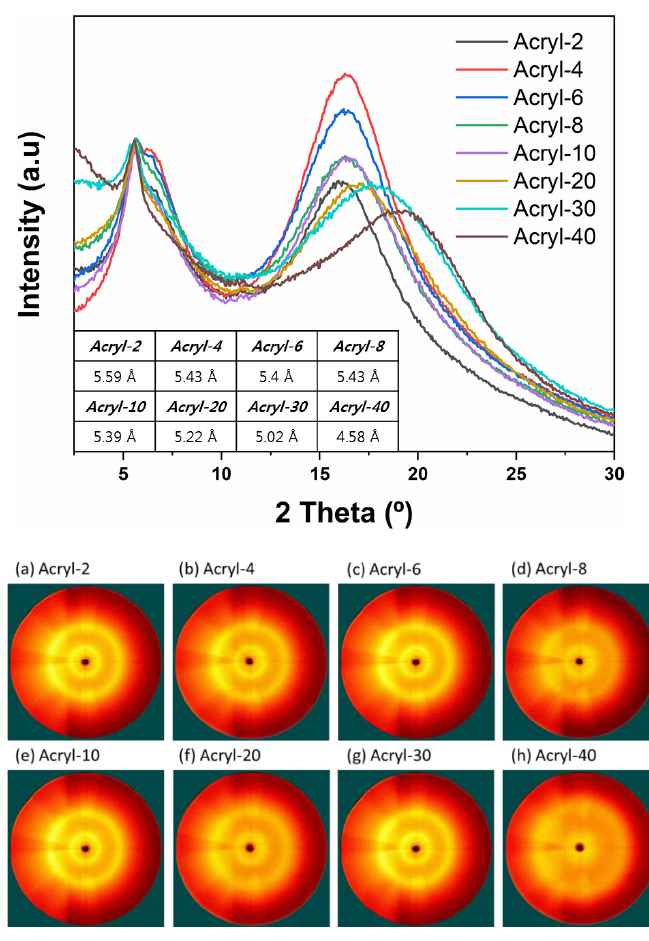
Figure 5. XRD pattern (up) and WAXS image (down) of acrylic PSA films for hydrophilicity.